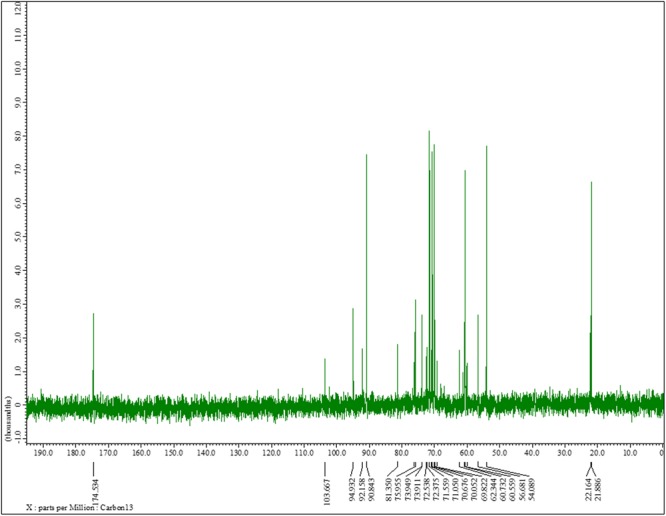
13C nuclear magnetic resonance spectra of the sugar content. 13C NMR (125 MHz, D2O): δ174.5, 103.6, 94.9, 92.1, 90.8, 81.3, 75.9, 73.9, 73.9, 72.5, 72.3, 71.5, 71.0, 70.6, 70.0, 69.8, 62.3, 60.7, 60.5, 56.6, 54.0, 22.1, 21.8. One can observe the chemical shift for α-l-rhamnose at 174.5 ppm in the spectrum. The carbon signals at 73.911 and 70.676 ppm were assigned to α-D-glucose, while carbon signal for β-D-glucose was detected at 60.732 ppm. The two carbon signals for β-pyranose can also be seen in the 13C spectrum at chemical shift 70.676 and 60.732, respectively.